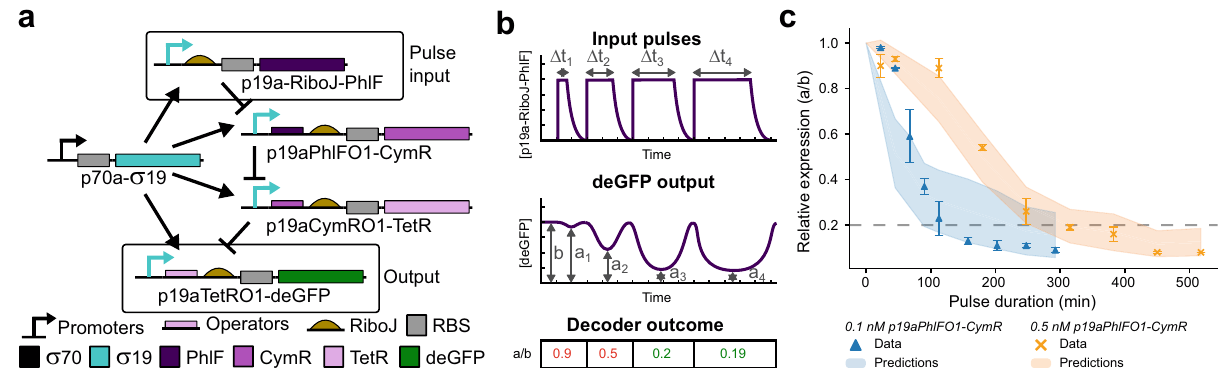
Fig. 4 Predicting the behaviour of a pulse decoder. a schematic of the pulse decoder network. b Schematic overview of the experimental procedure. A longer duration pulse of p19a-RiboJ-PhlF ( Δ t ) results in a lower relative expression (a/b). c Data plotted as relative concentration (a/b) against pulse duration for two system con fi gurations (0.1 nM in blue and 0.5 nM p19aPhlFO1-CymR in orange). Error bars indicate the mean and standard deviation over two measurements. The standard deviation of the mean for the fi rst quantile of highest scoring simulations (predictions) is plotted as shaded areas in corresponding colours.